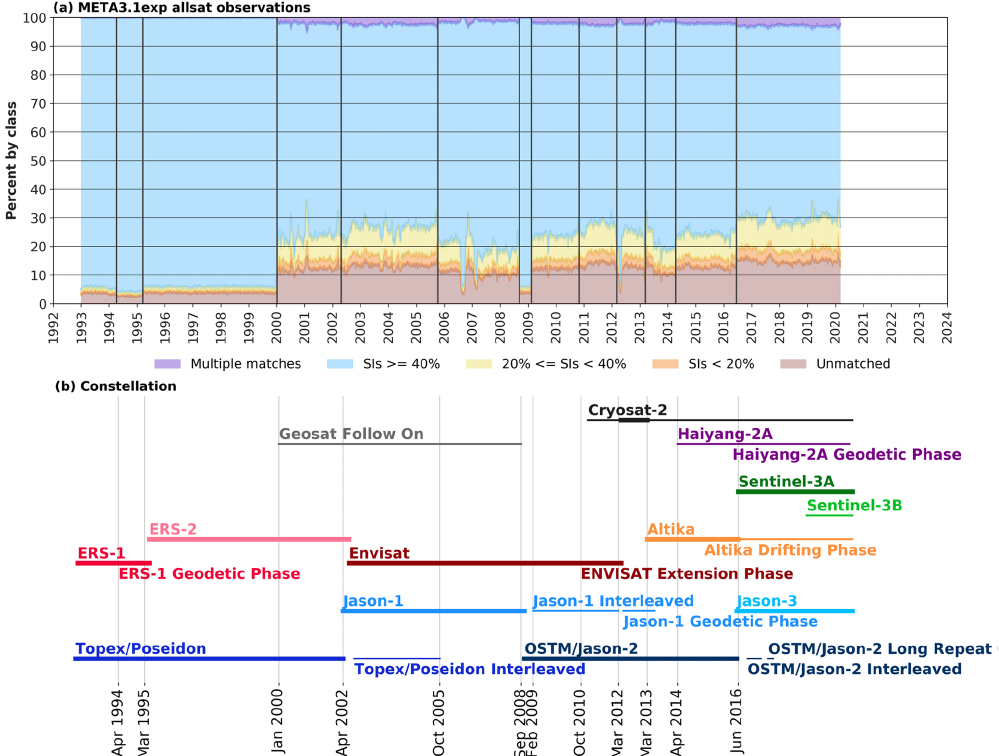
Figure 4. (a) Temporal evolution of the SC distribution obtained for the all-satellites META3.1exp, compared with the two-satellites META3.1exp. The percentage of unmatched observations (brown shading) represents eddies detected in the all-satellites product but ab- sent in the two-satellites atlas. The low and intermediate SCs ( < 40%, orange and yellow shading) highlight eddies with shifted locations. Eddies similarly detected in the all-satellites and two-satellites products represent most of the eddies (SCs ≥ 40%, blue shading). Eddies with multiple matches (purple shading) are few. (b) Temporal evolution of the satellite constellation used for the two-satellites (thick lines, reference missions) and the all-satellites (thick and thin lines) products. The highlighted changes in the missions correspond to some abrupt variations in the